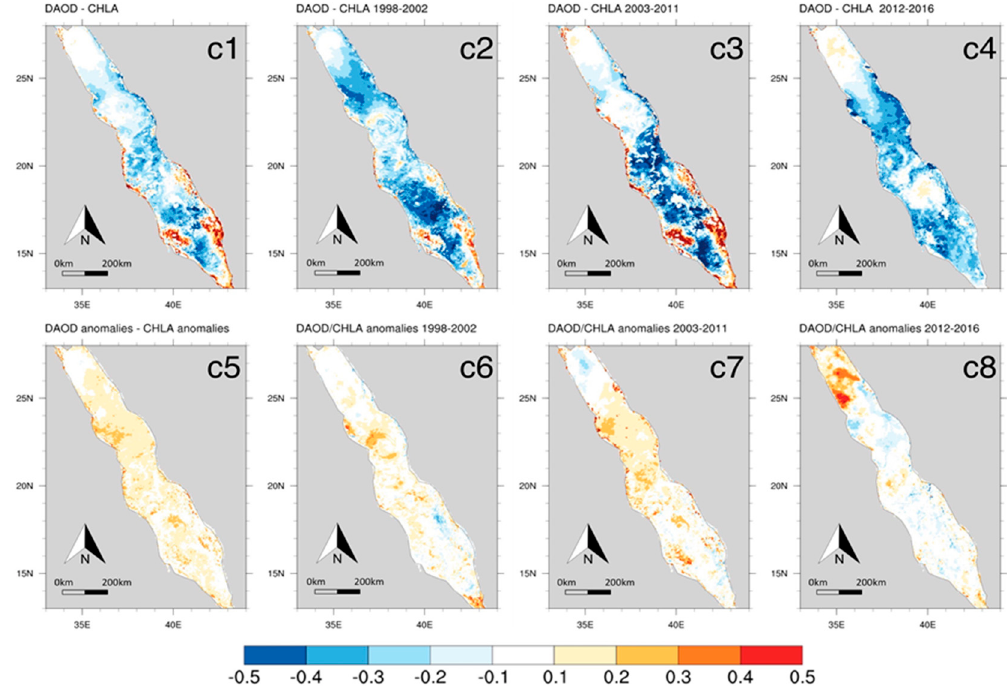
Figure 4. Cross Correlation analysis at lag 0 for actual values and anomalies of SST ( a1 – a8 ), WINDSPEED ( b1 – b8 ) and DAOD ( c1 – c8 ) (MERRA-2 Dust Scattering Aerosol Optical Depth (AOT) in 550 nm) with Chl- a , for entire period (1998–2016) (first column), before MERIS (1998–2002) (second column), during MERIS (2003–2011) (third column), and after MERIS (2003–2011) (fourth column).